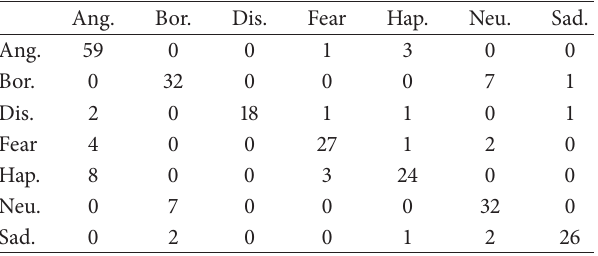
Table 4: Confusion matrix of Γ , 𝑃 3 feature set. The left column denotes actual emotions, and the top row represents predicted emotions.